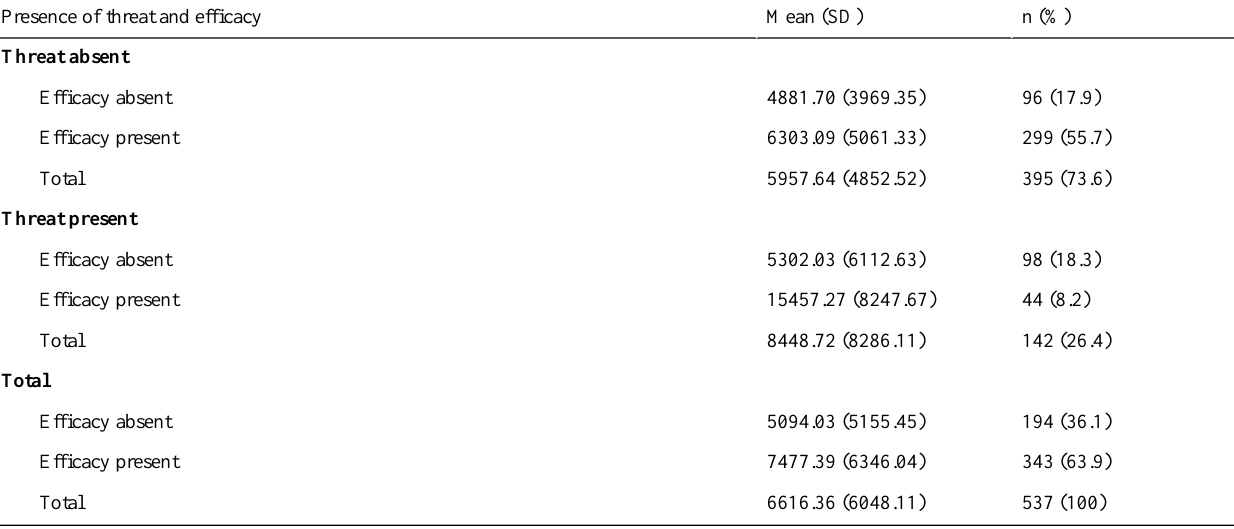
Table 1. Descriptive statistics for the number of readings (N=537).